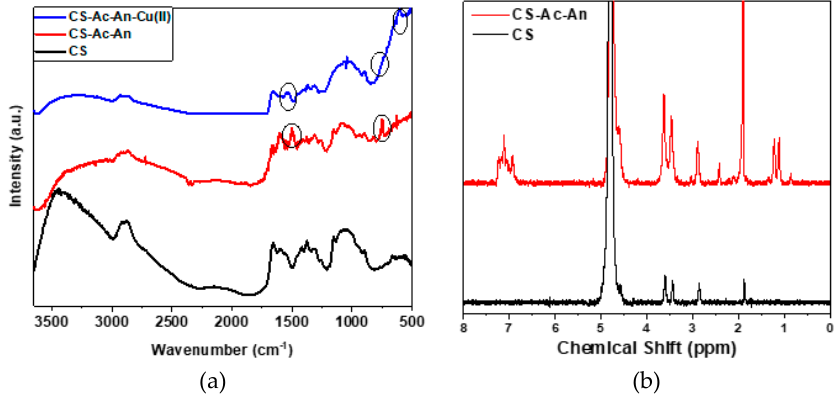
Figure 1. ( a ) FT ‐ IR spectra of pristine chitosan (CS), CS ‐ Ac ‐ An, and CS ‐ Ac ‐ An ‐ Cu(II) (after adsorption). ( b ) 1 H ‐ NMR spectra of pristine chitosan (CS) and CS ‐ Ac ‐ An (before adsorption).